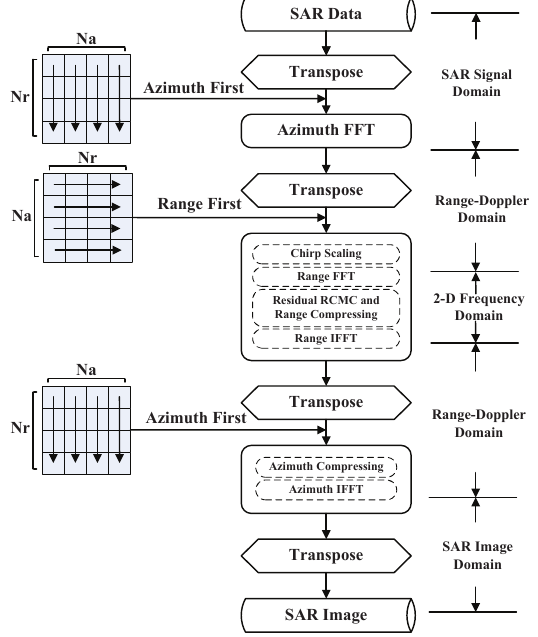
Figure 1. The chirp scaling algorithm